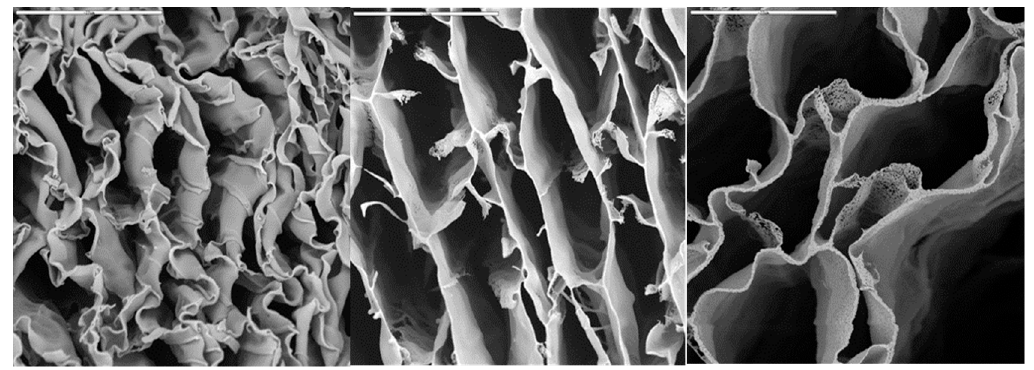
Figure 4. SEM micrographs of different hieratical structures resulting from the calcination of CSCaP nanocomposites. From left to right: CSCaP1C, CSCaP2C and CSCaP3C. Bars are 20 µm.